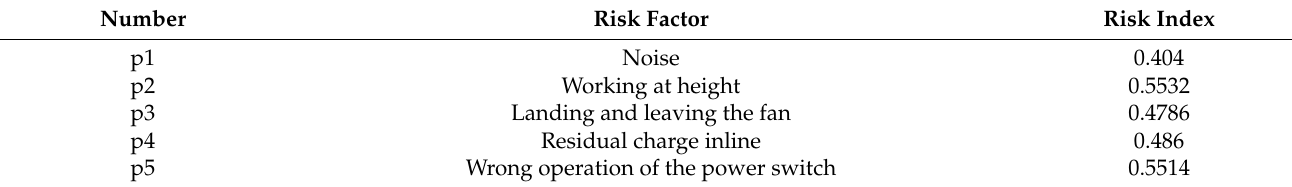
Table 6. Personnel injury risk factors of offshore wind